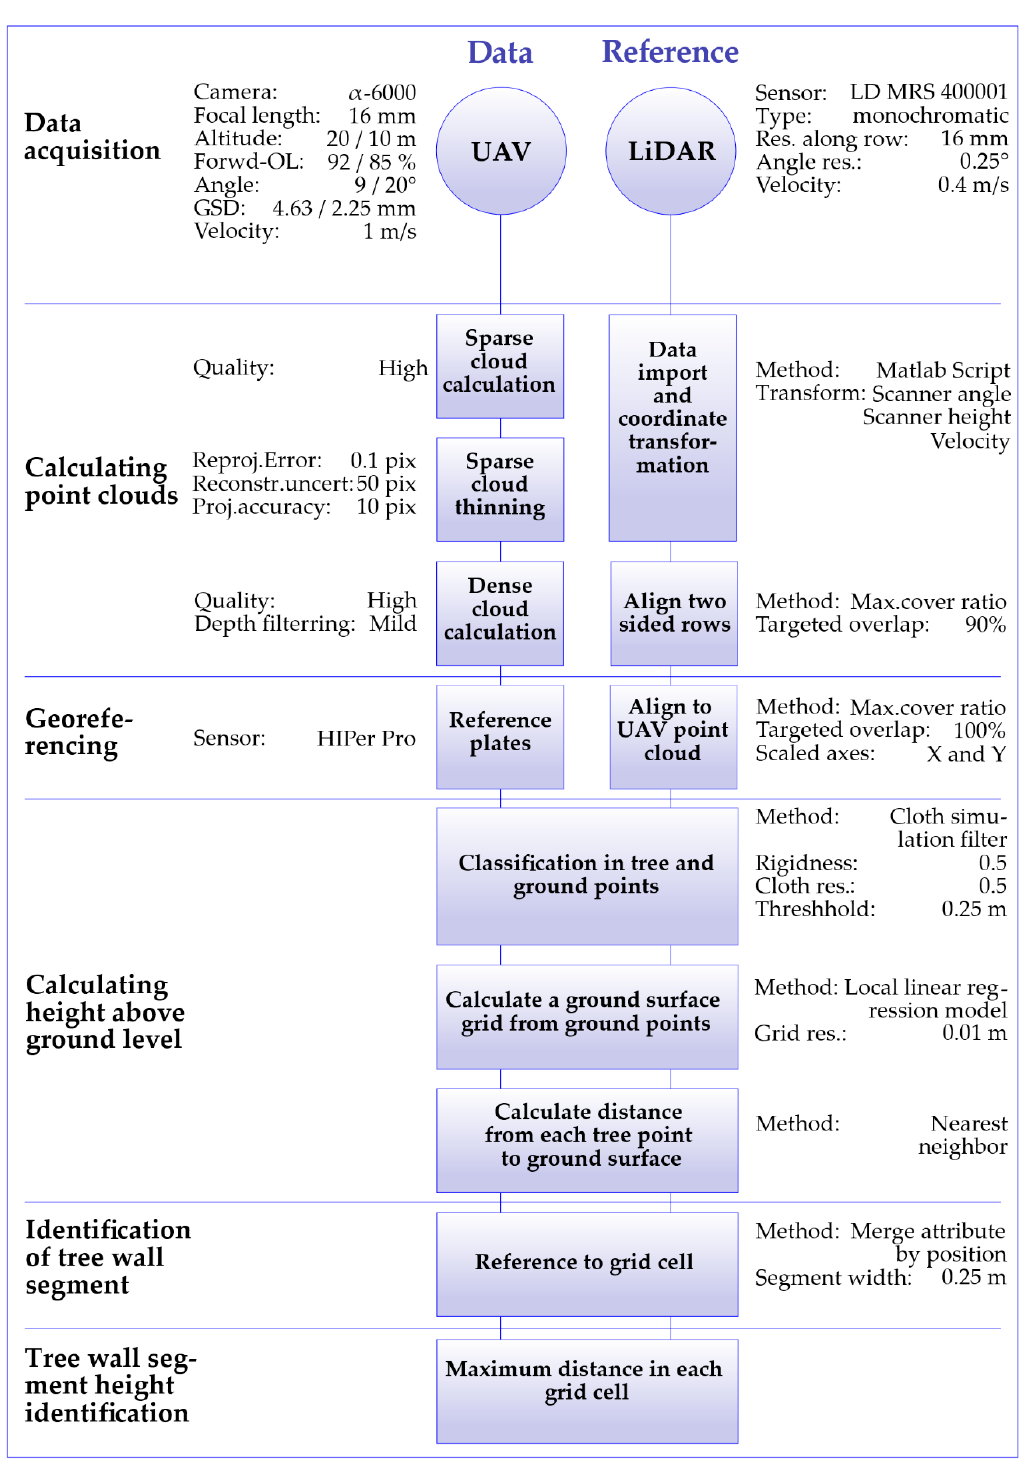
Figure 2. Overview of data processing steps and their main parameter settings.